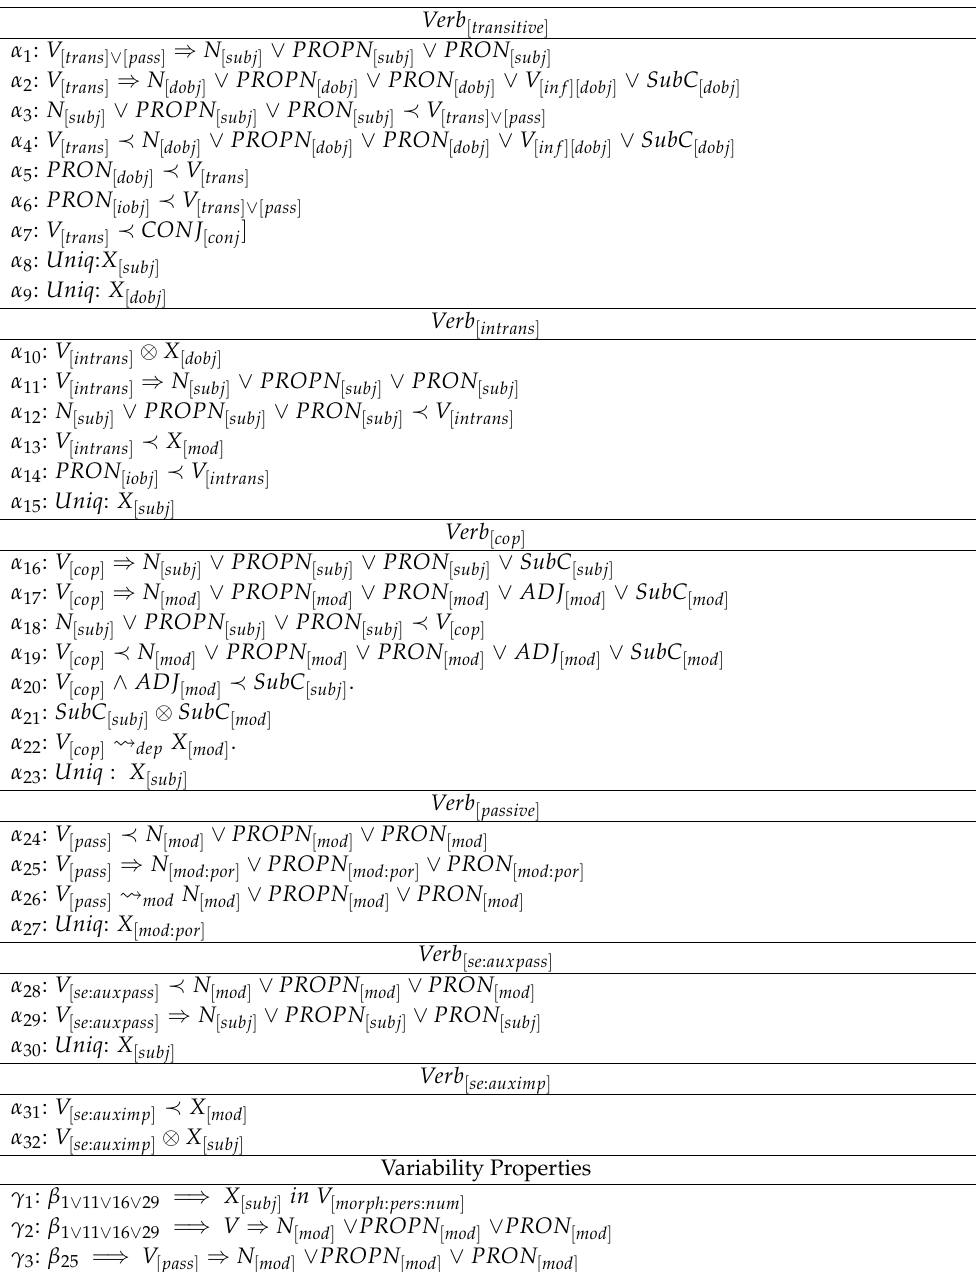
Table A8. Table of Spanish properties of verb in verbal construction. Verb in Verbal